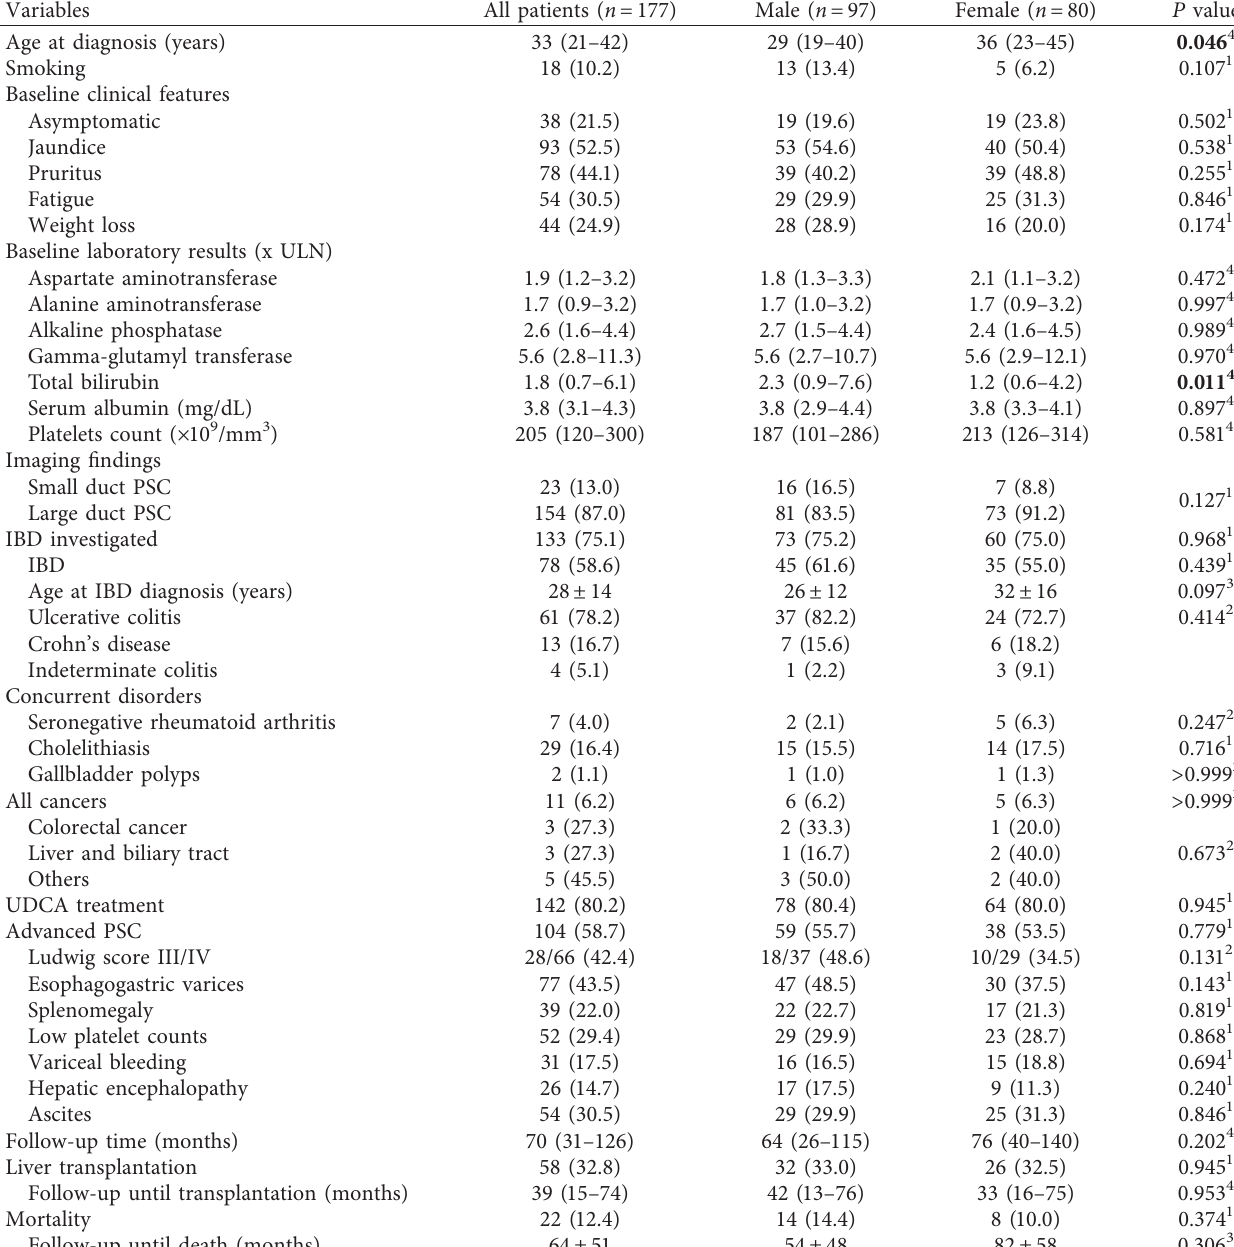
Table 1: Demographics, clinical, and laboratory features of patients with PSC according to